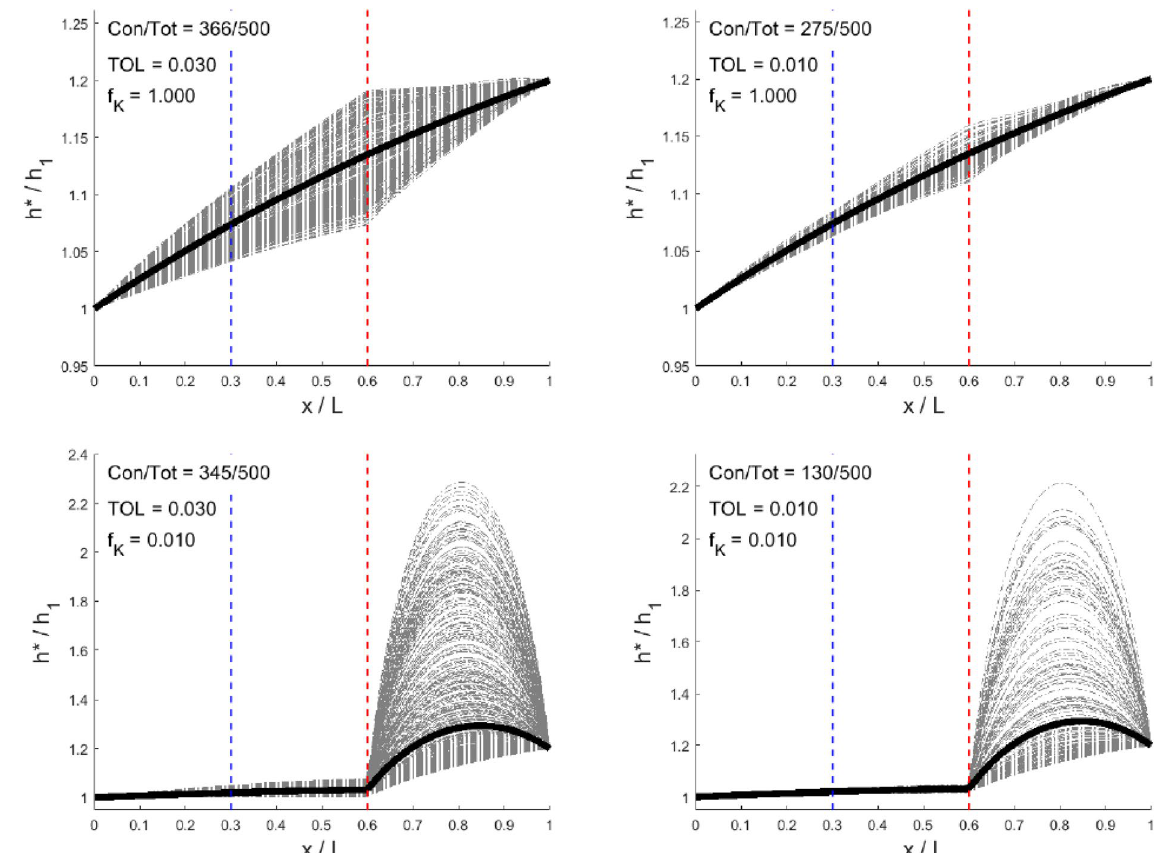
between materials x K and blue line shows position of well with measured head x w . Note: f K corresponds to ratio between both scales of hydraulic conductivity, k 1 and k 2 , thus for f K = 1.0 , K 1 ∕ K 2 ranges between [ 0.01,100.0